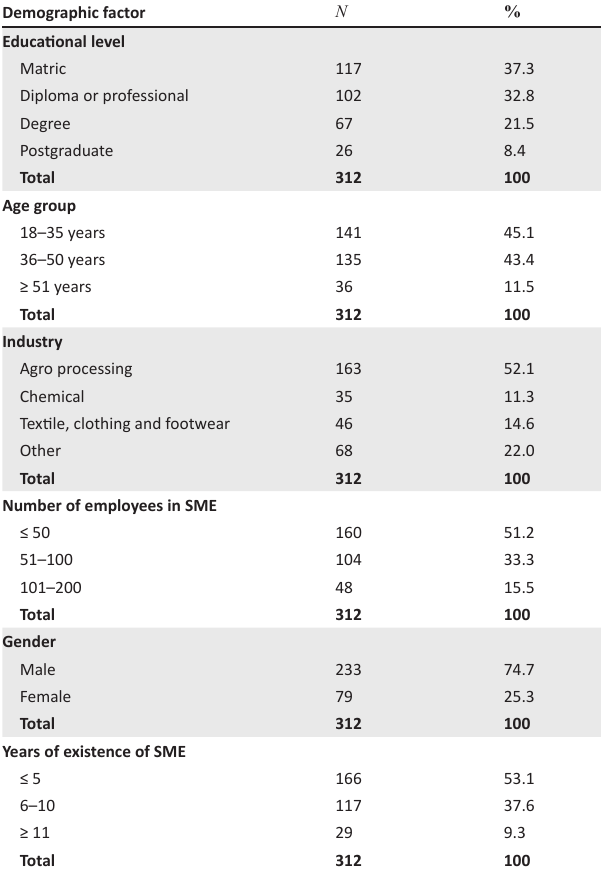
TABLE 2: Demographic profile of respondents. Demographic